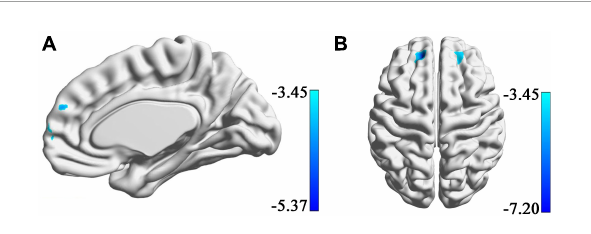
FIGURE4 Regions showing correlations between rsFC with amygdala and the stress responses in a sample consisting of 30 participants who completed both of the first and the second surveys. (A) A cluster in the dmPFC whose rsFC with the right amygdala correlated with the score of SBSC at the first survey. (B) Bilateral superior frontal gyri whose rsFC with the right amygdala correlated with the score of SBSC at the second